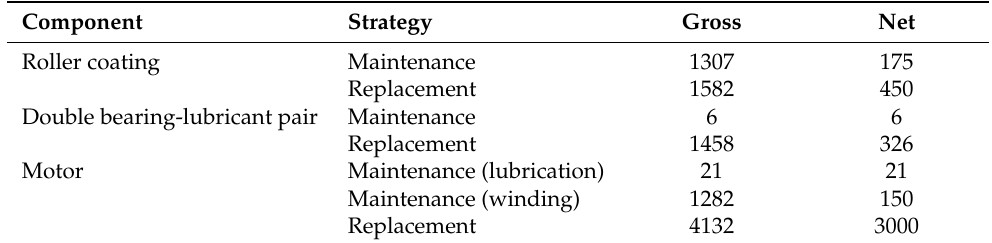
Table 18. Direct costs (EUR) during strategies for every roller coating, double bearing-lubricant pair and motor of the bleaching machine (ZORLUTEKS).